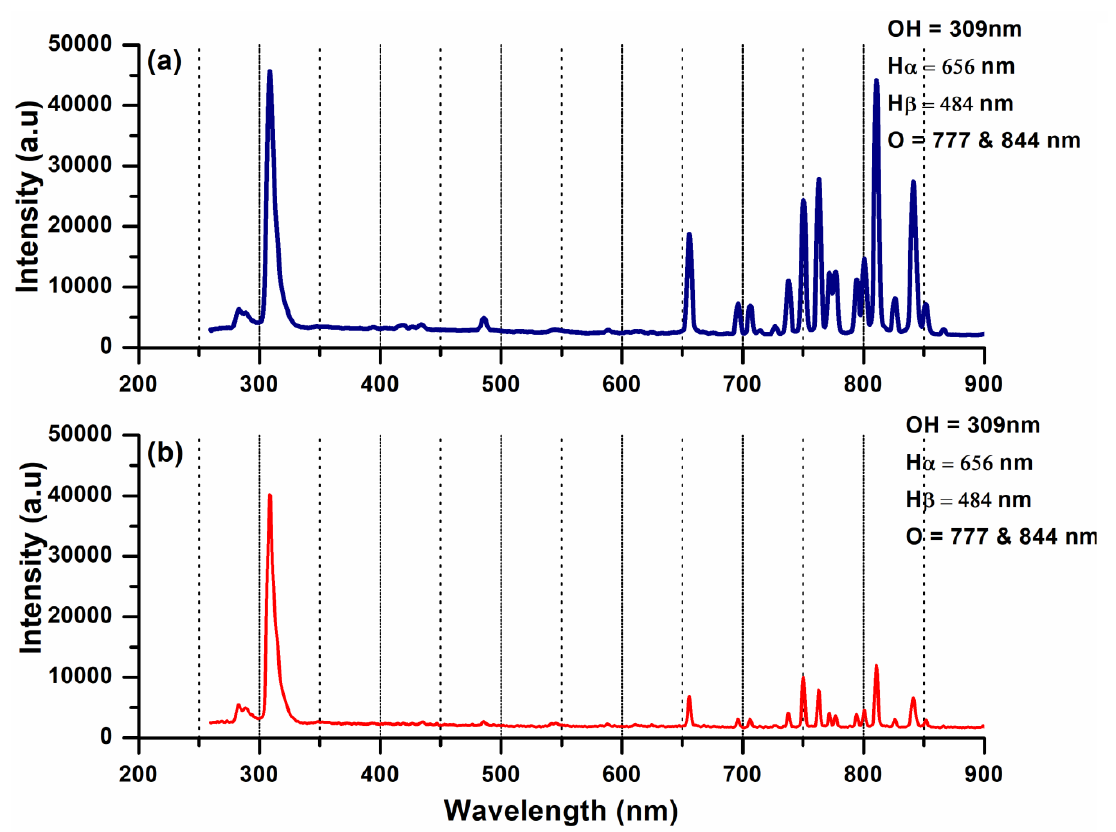
Figure 3. Emission spectrum of plasma discharge: ( a ) with H 2 O 2 vapors; ( b ) without H 2 O 2